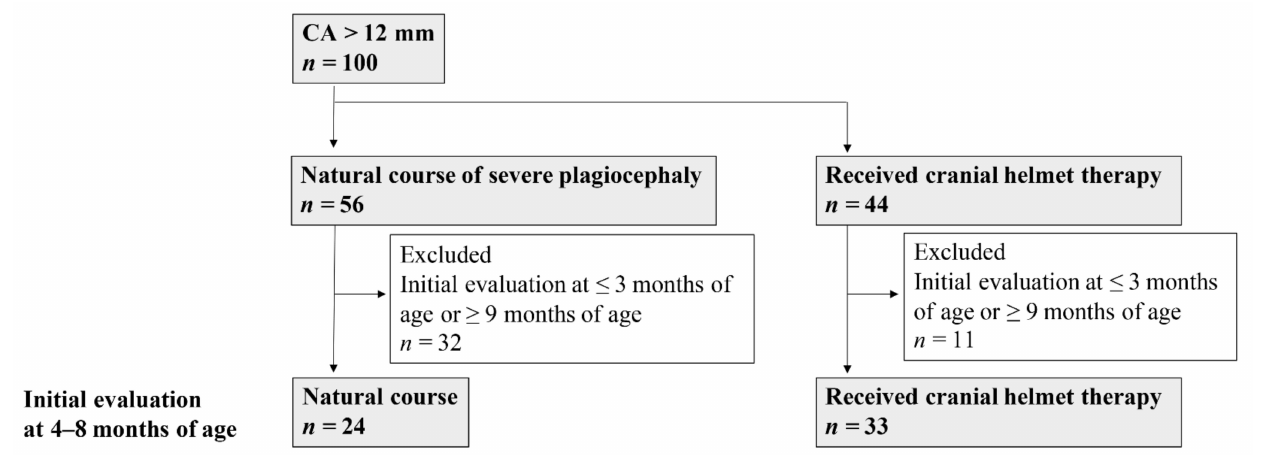
Figure 2. Flowchart of the enrolled infants with severe plagiocephaly in the natural-course and CHT groups for Study 2. CA, cranial